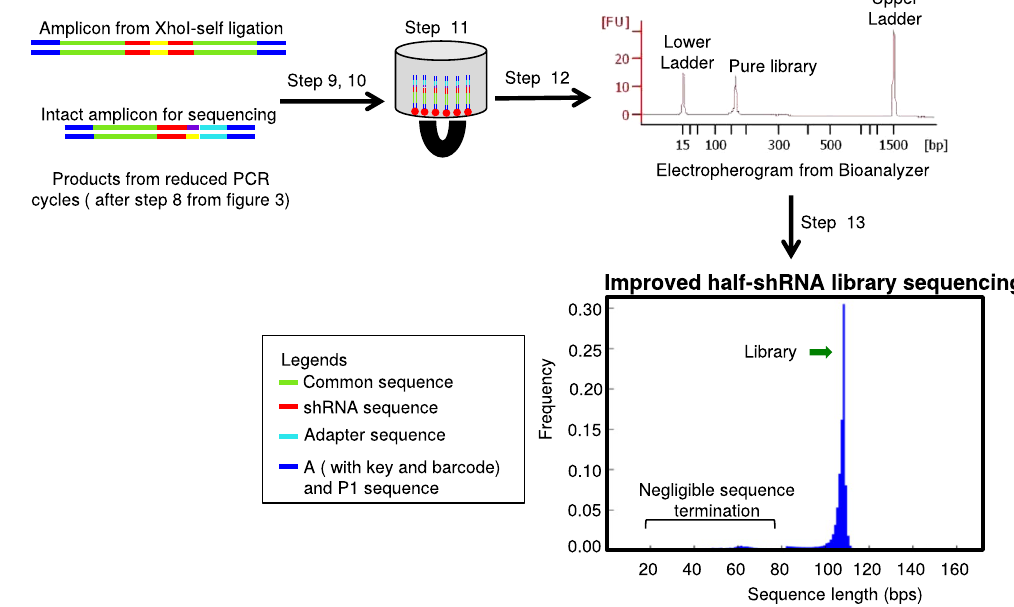
Figure 4. Reducing heteroduplex formation in half-shRNA library. Workflow showing steps to reduce heteroduplex formation in half-shRNA library. Step 1-8: same as in Fig. 3. Step 8: PCR purification of the barcoded PCR product. Step 9: XhoI digestion of the amplicon from XhoI self-ligated product. Step 10: PCR amplification after digestion of amplicon from XhoI self-ligation. Step 11: Magnetic bead-based purification of the barcoded product. Step 12: Quality assessment of the barcoded product on the Bioanalyzer. Step 13: Half- shRNA library sequencing on Ion Torrent platform. Representative agarose gel, the electropherogram from the Bioanalyzer, read-length histogram from Ion Torrent are shown. The sequence length is plotted in the X-axis and the frequency is plotted in the Y-axis. For half-shRNA, library is 108 bp excluding A and P1